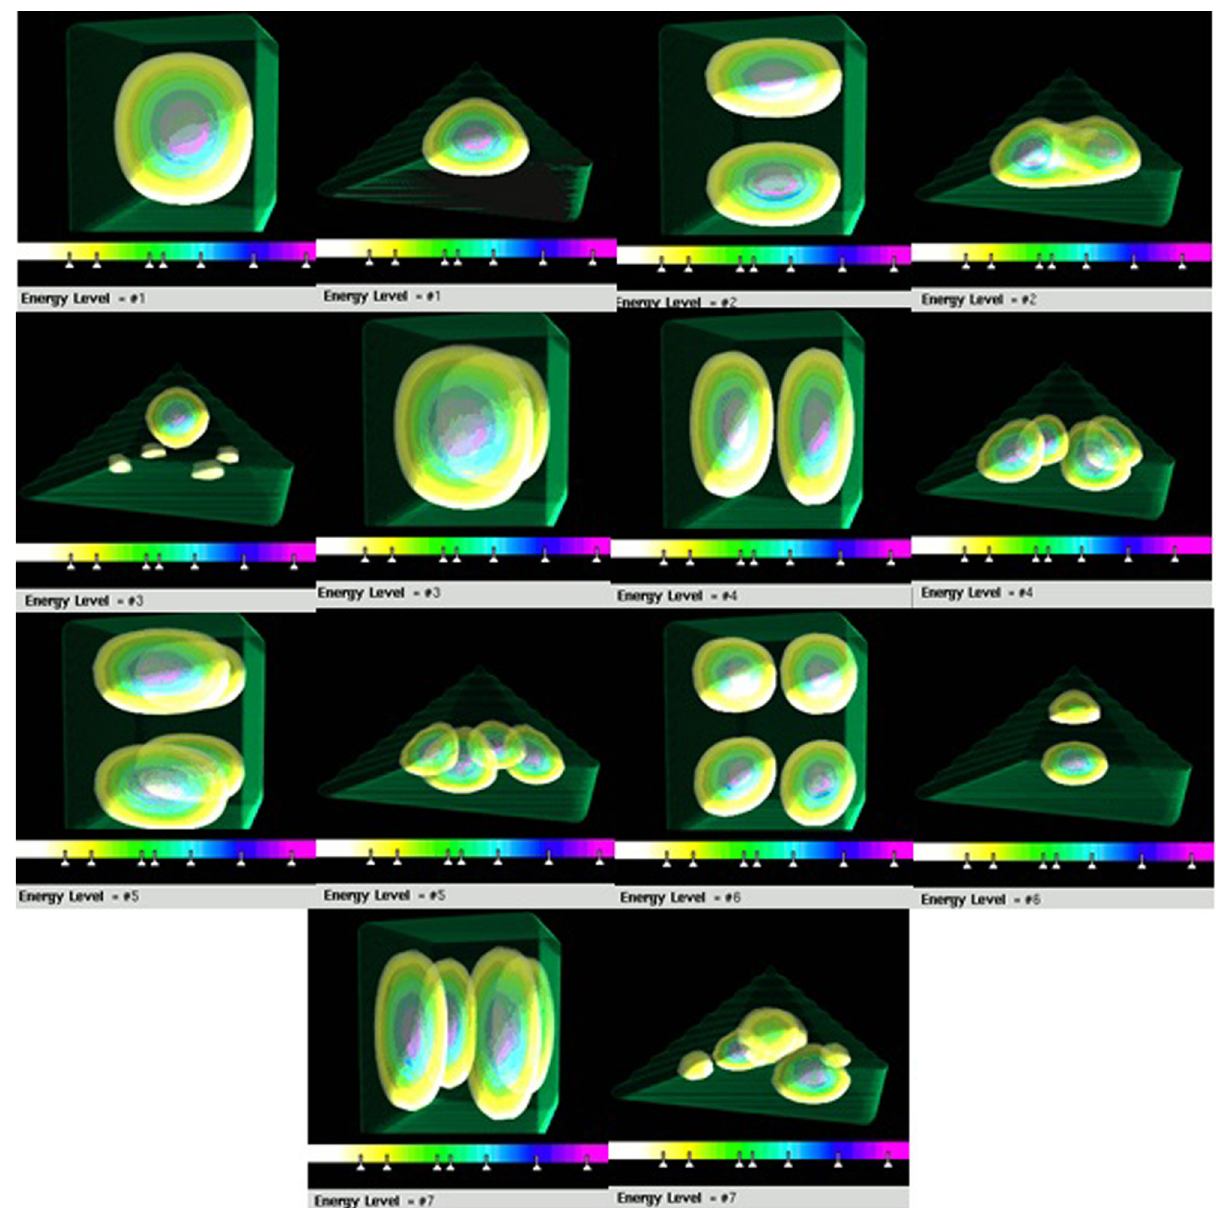
Figure 4: 3D con fi ned electron wave functions in a quantum